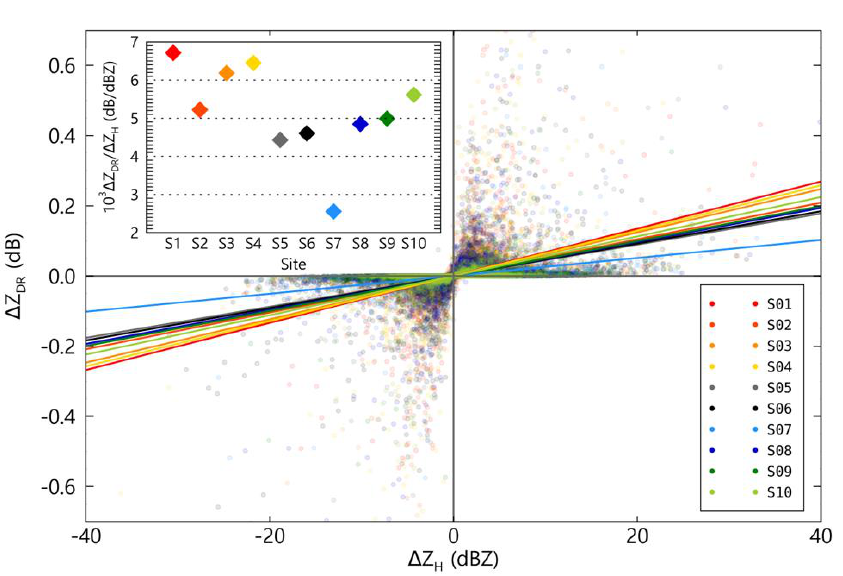
Figure 15. The fitting lines for ΔZ DR versus ΔZ H . The inside graphs show the parameters of the relationships. The colored solid lines indicate each Parsivel site.